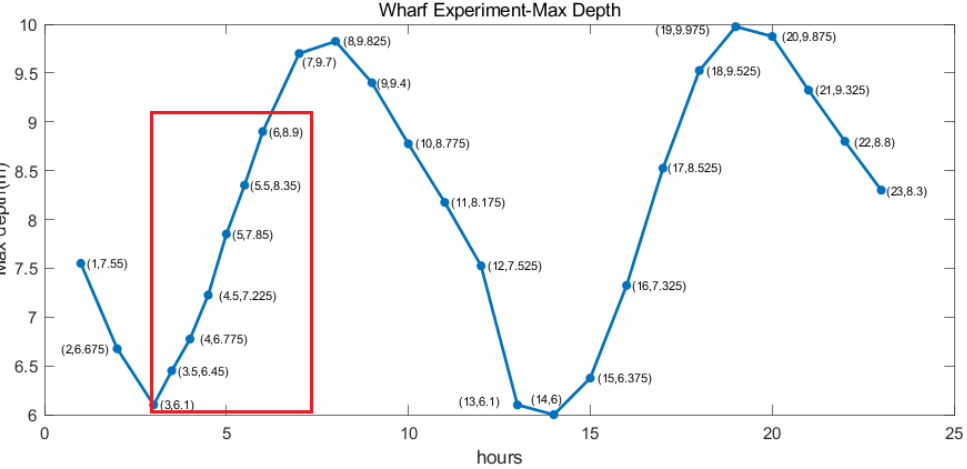
Figure 16. Wharf experiment max depth . the red box part is the acquisition frequency set to twice an hour through remote communication